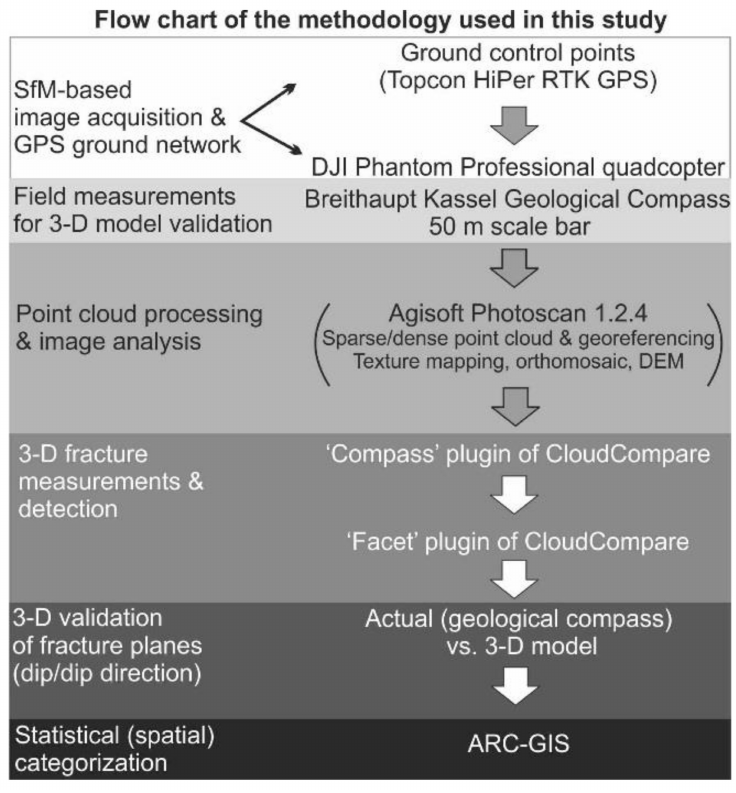
Figure 2. Workflow adopted in this study (right side). Explanation of each step is summarized on the (left